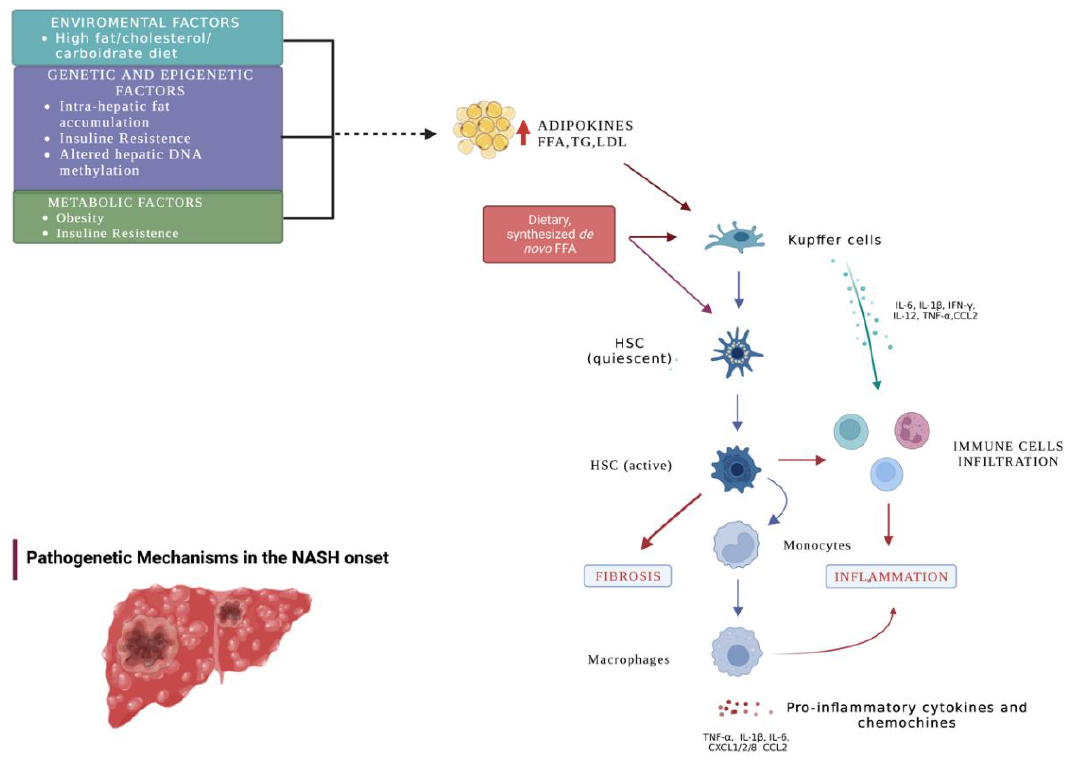
Figure 3. Pathogenic mechanisms in the development of NASH. Environmental, genetic, and metabolic factors are thought to be involved in the pathogenesis of NASH. Changes in the intestinal microbiome result in increased serum FFA and proinflammatory cyto/chemokine levels, believed to be the leading causes of progression to NASH. Activation of liver KCs results in the release of CCL2 TNF α , IL-1, IL-6, and other proinflammatory cytokines, leading to the recruitment of immune system cells, hepatic stellate cell activation, and macrophage-mediated